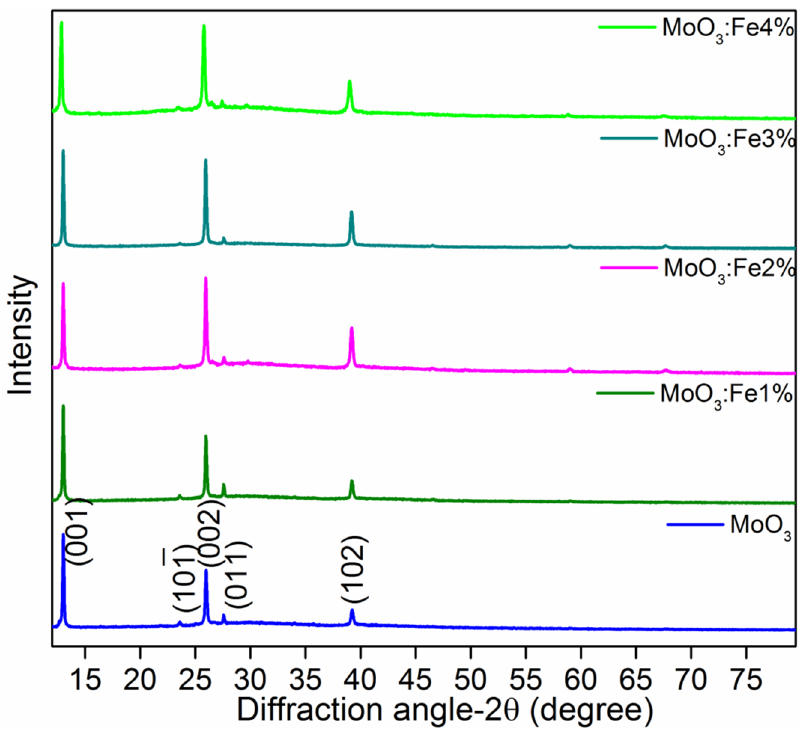
Figure 1. XRD patterns of Fe doped MoO 3 thin films.